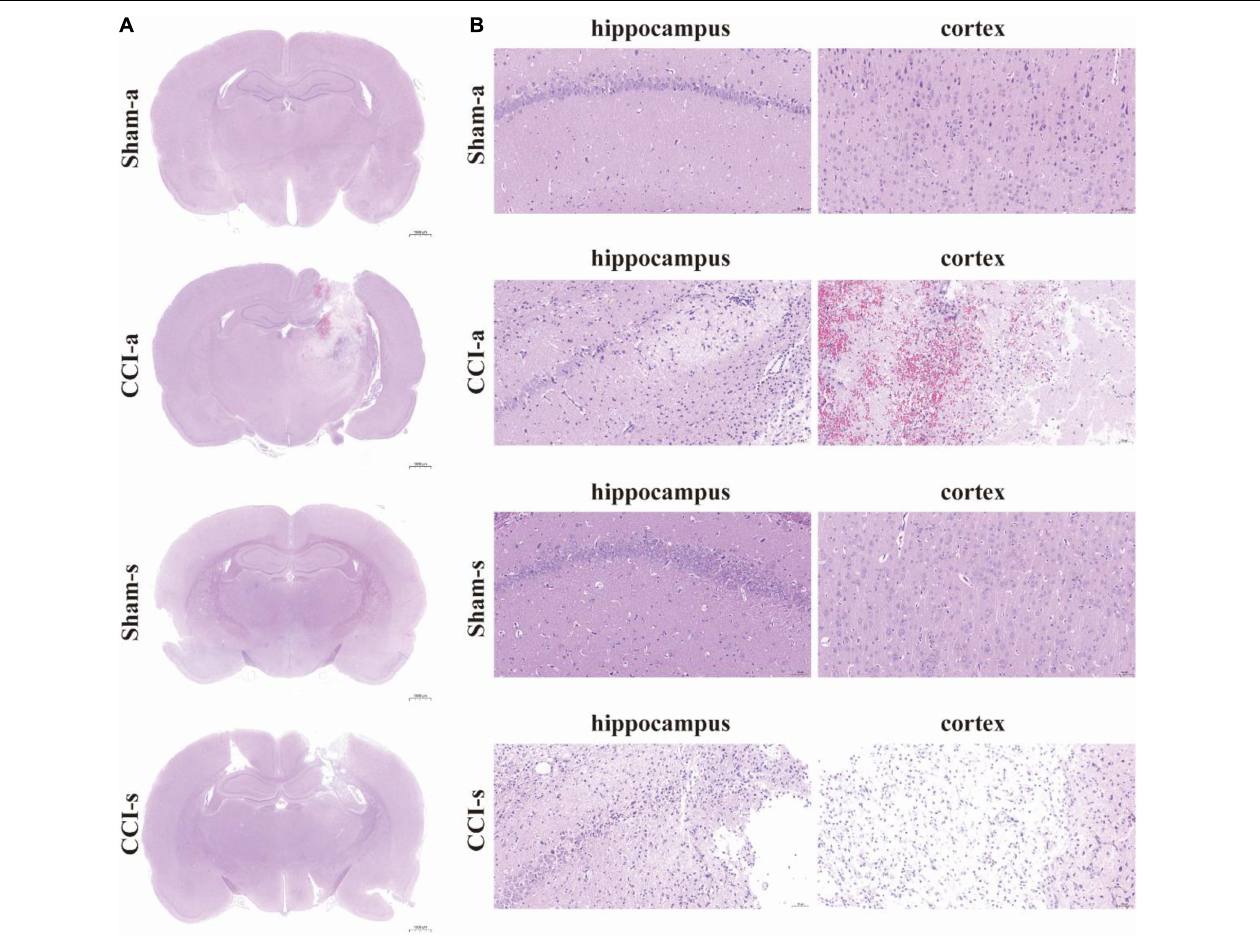
FIGURE 3 | H&E staining of brain tissues. (A) The brain sections in different groups were stained with H&E and examined by high magnification. (B) H&E staining of cortex and hippocampus of the injured side. Sham-a, a sham-operated group of acute, CCI-a, CCI-operated group of acute, Sham-s, a sham-operated group of subacute; CCI-s, CCI-operated group of subacute